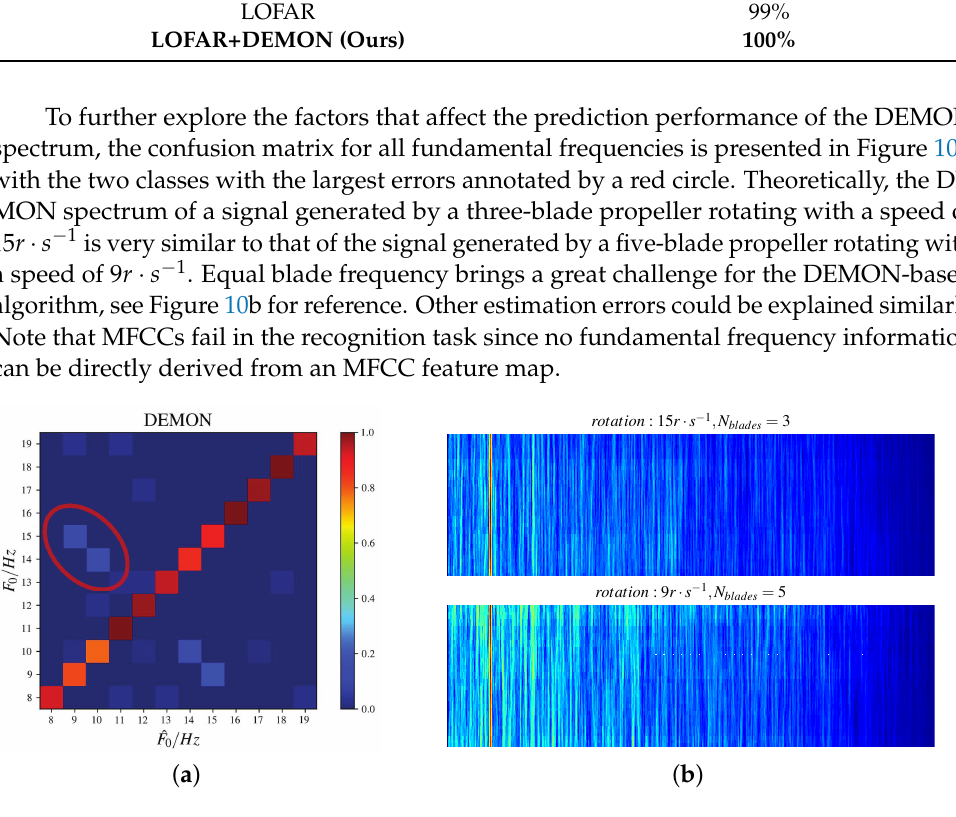
Figure 10. Feature spectrum of noises with the same blade frequency leading to classification errors. The confusion matrix for all fundamental frequencies is presented in ( a ). The red circle marks the largest classification errors, and the corresponding DEMON spectrum of one category is displayed in ( b